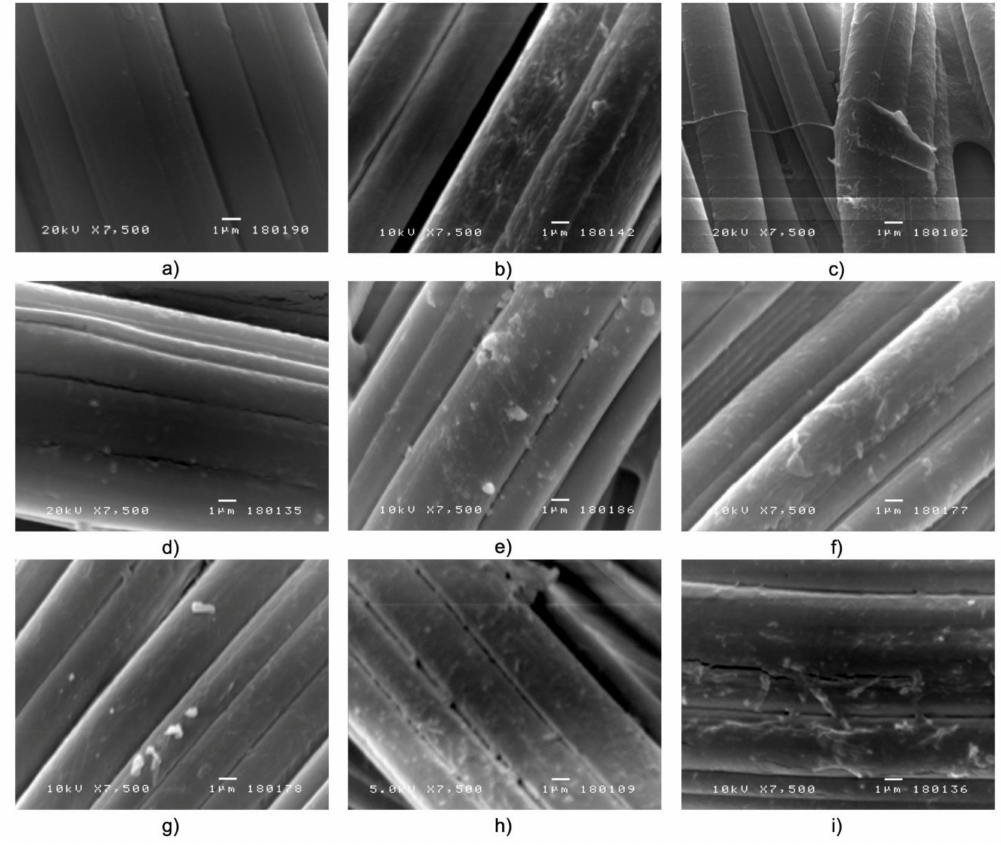
Figure 4. SEM images of CV ( a ), TEMPO CV ( b ), TOCN CV ( c ), CV/NCS ( d ), TEMPO CV/NCS ( e ), TOCN CV/NCS ( f ), CV/NCS + Zn ( g ), TEMPO CV/NCS + Zn ( h ), TOCN CV/NCS + Zn ( i